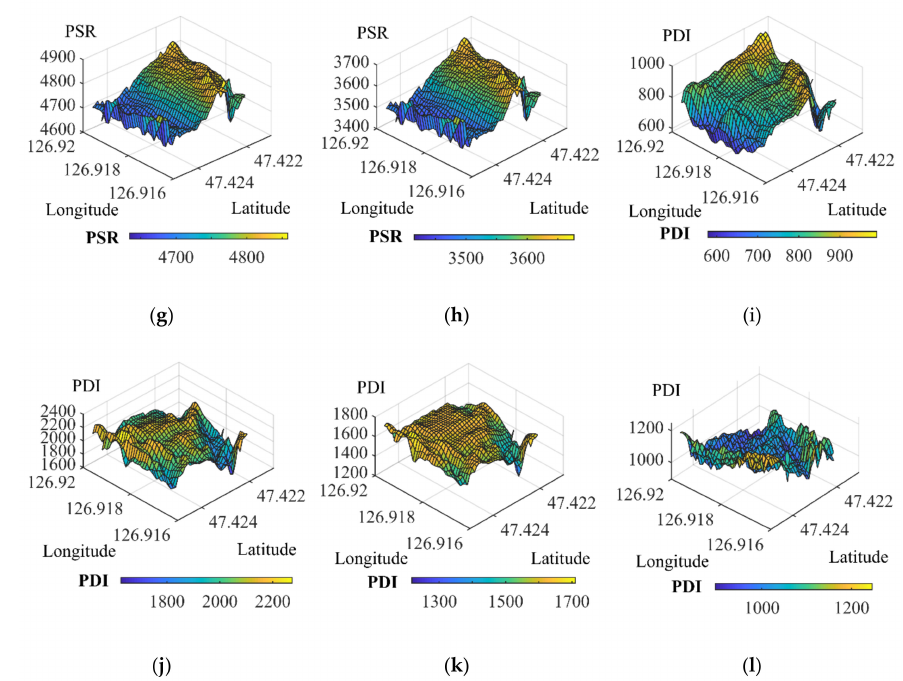
Figure 4. Normalized di ff erential vegetation index (NDVI), potential solar radiation (PSR) and perpendicular drought index (PDI) spatial distributions from June to September (( a – d ) represent the June, July, August, and September NDVIs; ( e – h ) represent the June, July, August, and September PSRs; ( i – k ), and ( l ) represent the June, July, August, and September PDIs,